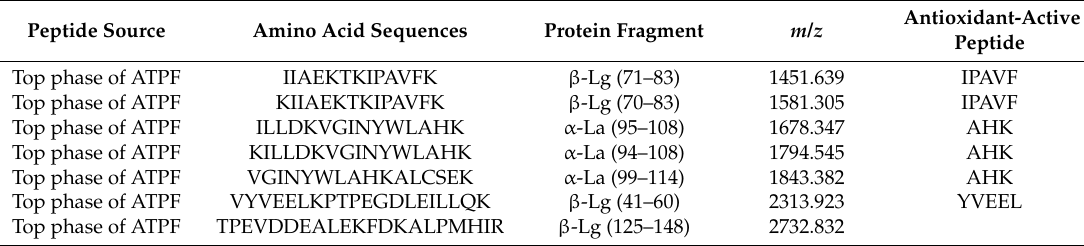
Figure 7. MALDI-TOF spectrum of peptides purified of top phase in ATPF. Table 3. Amino acid sequence of peptides of top phase in